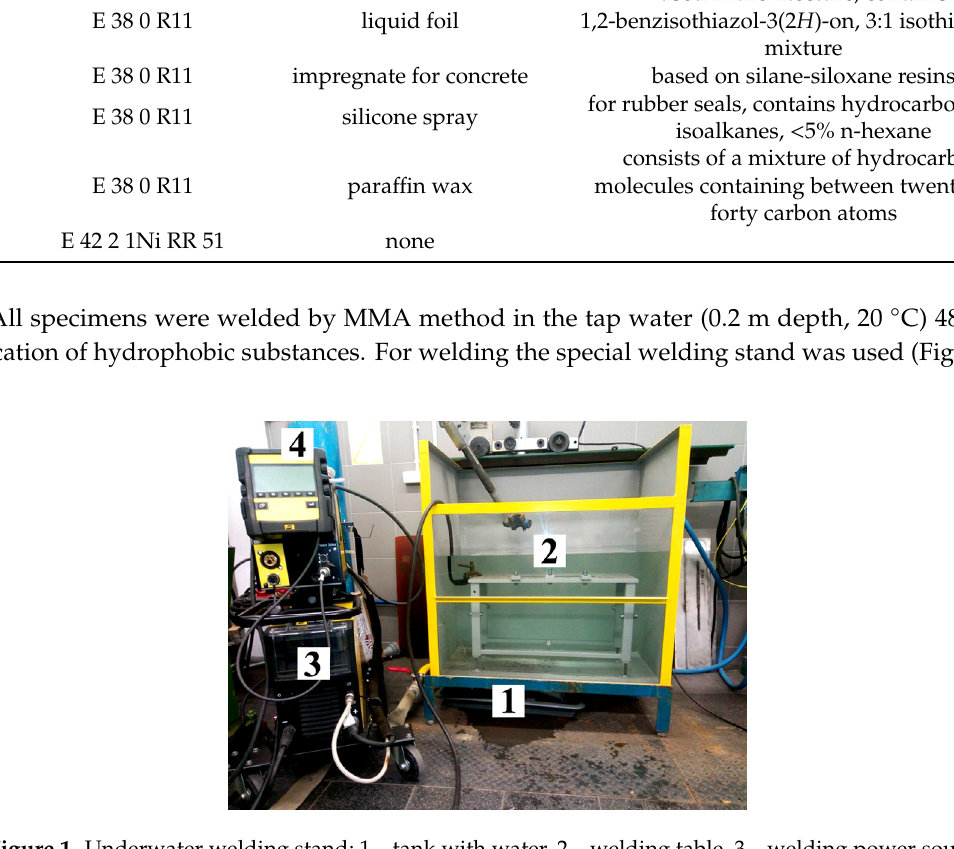
Figure 1. Underwater welding stand; 1—tank with water, 2—welding table, 3—welding power source, 4—control panel.